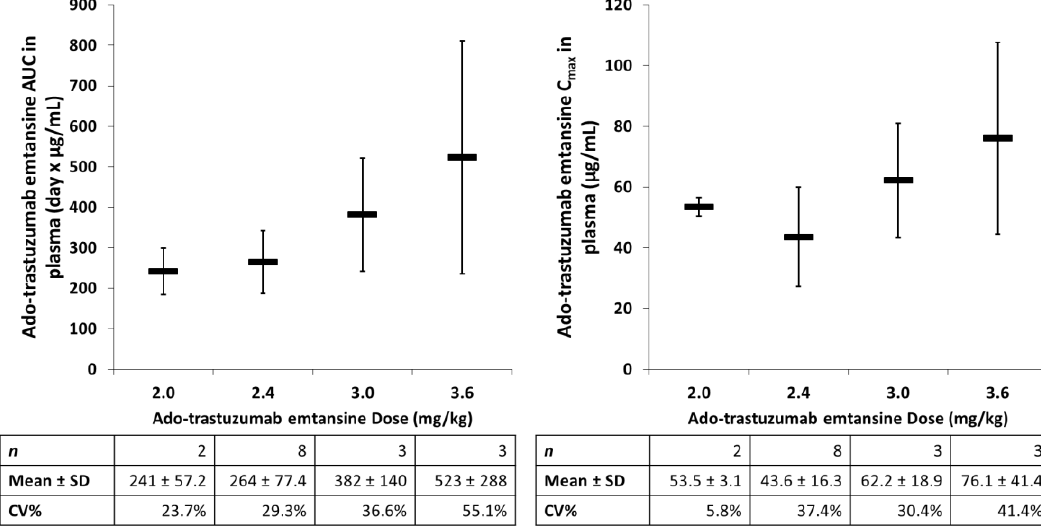
Figure 3. Relationship between ado-trastuzumab emtansine dose and AUC or Cmax in plasma. Mean ± standard deviation (SD) of patients for each treatment group are represented by the black bar. There was high interpatient pharmacokinetic (PK) variability in ado-trastuzumab emtansine, especially when approaching important PK doses (i.e., maximum tolerable dose). The high PK variability of ado- trastuzumab emtansine may be associated with variability in the mononuclear phagocyte system (MPS). CV%, coefficient of